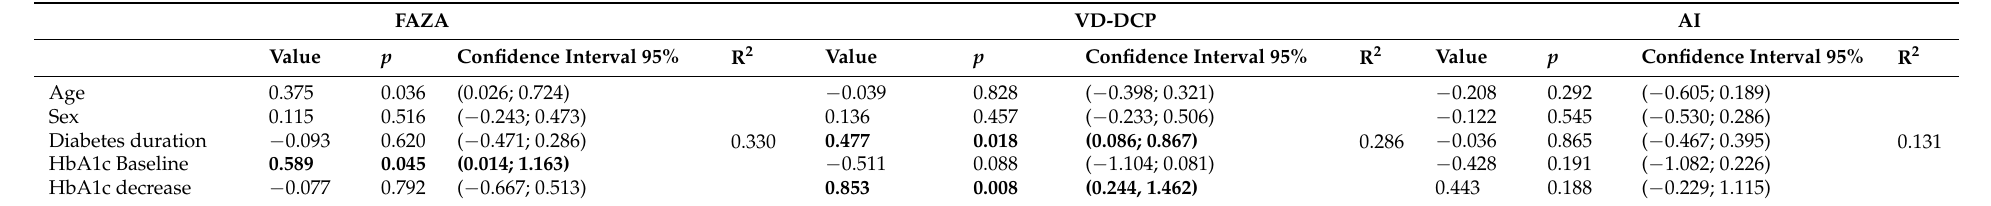
Figure 3. Variation in FAZA and VD-DCP plotted against baseline HbA1c and drop in HbA1c. Table 6. Multivariate analysis of the evolution of FAZA, VD-DCP, and AI according to age, sex, duration of diabetes, baseline HbA1c, and decrease in HbA1c.